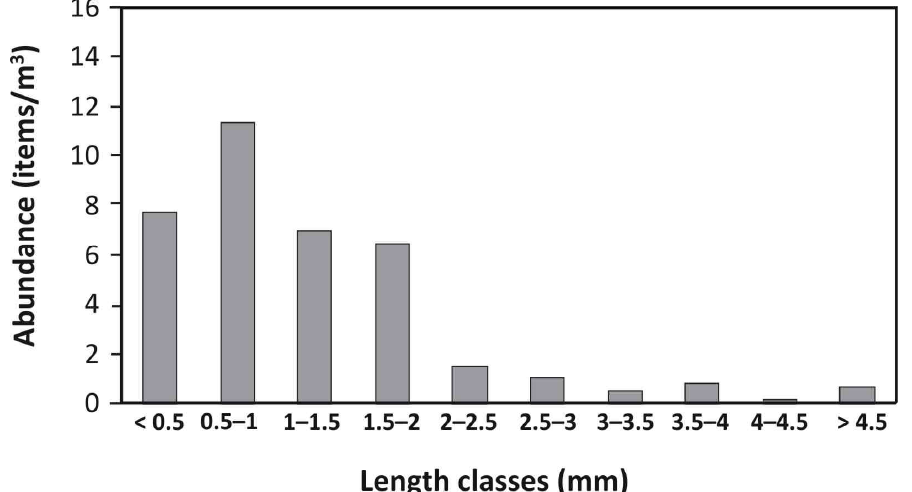
Figure 5. Length size distribution of the overall microplastic fibers (as items/m 3 ) recovered from the total number of samples collected in the four sampling areas (Latsi, Amathounta, Meneou and Protaras) during 2017–2019.